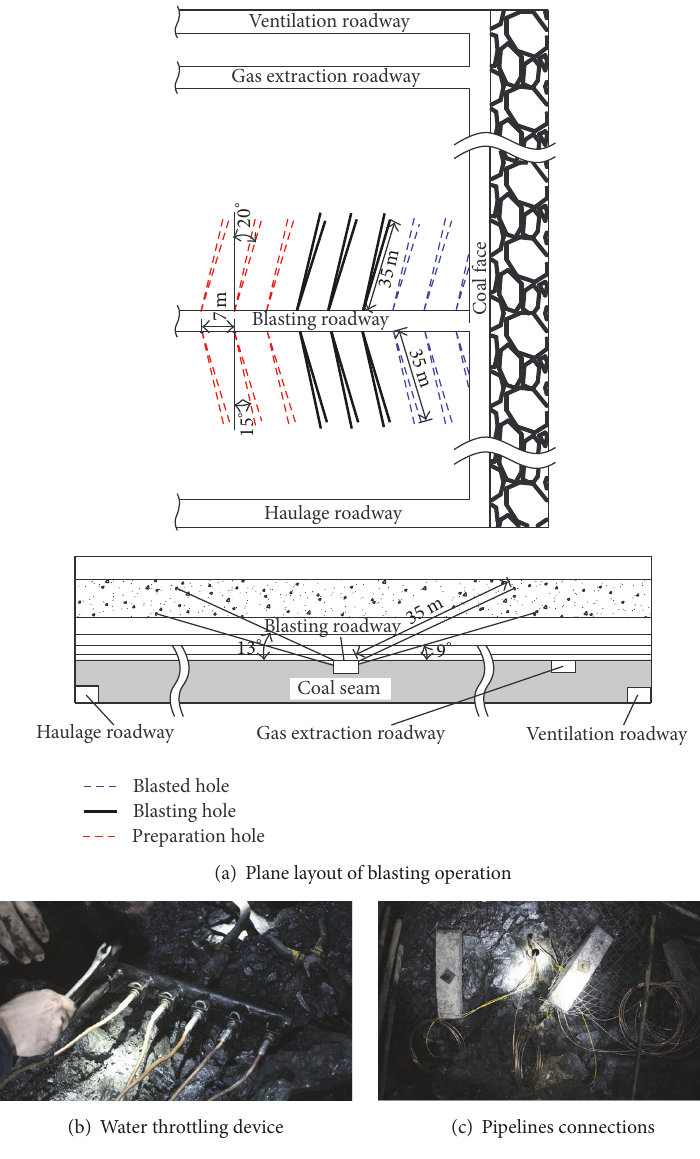
Figure 14: Plane layout of blasting operation and connections between pipelines.